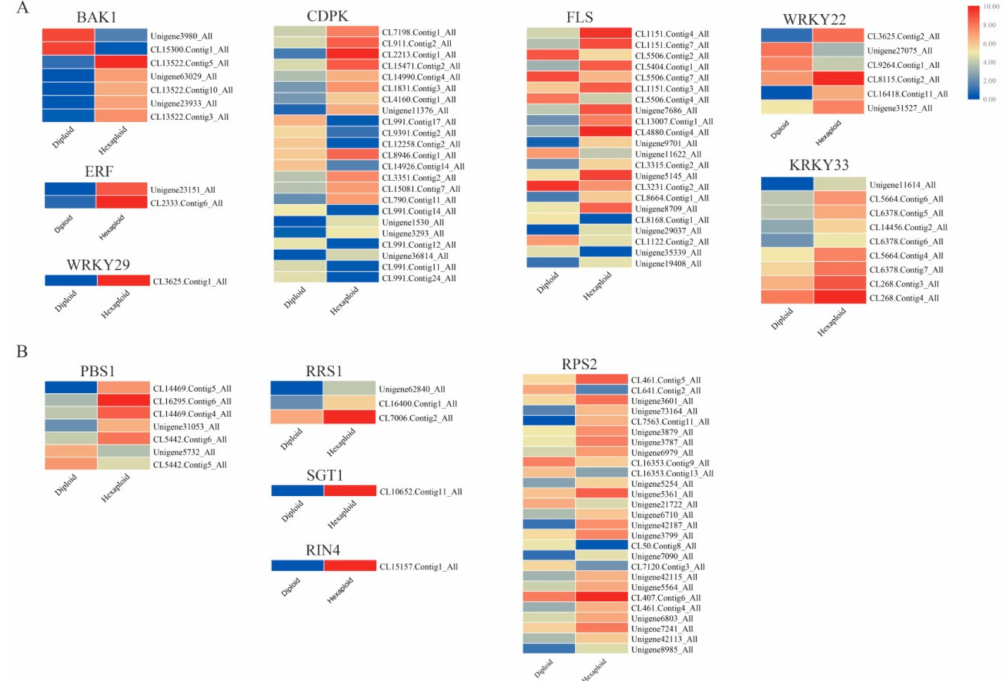
Figure 5. Expression profiles of DEGs related with plant-pathogen interaction pathway. Two major approaches include PAMP-triggered immunity (PTI) ( A ) and e ff ector-triggered immunity (ETI) ( B ). The color bar indicates the normalized relative expression levels; red indicates high expression level, blue indicates low expression level.